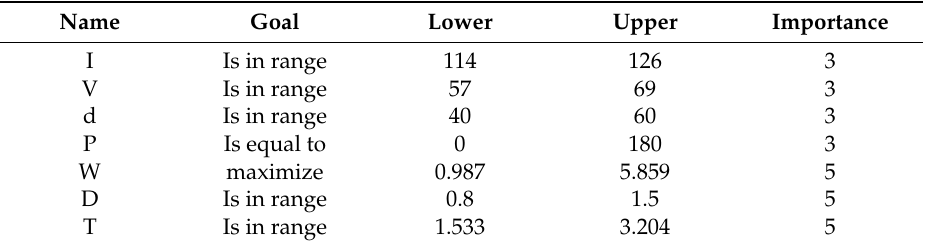
Table 8. Restraint of numerical